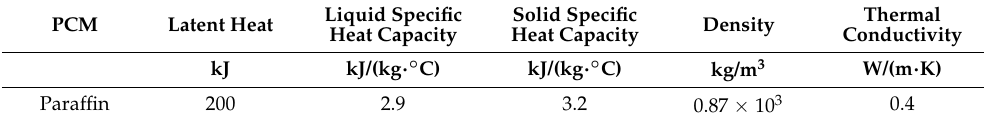
Table 1. Thermal properties of paraffin for test.